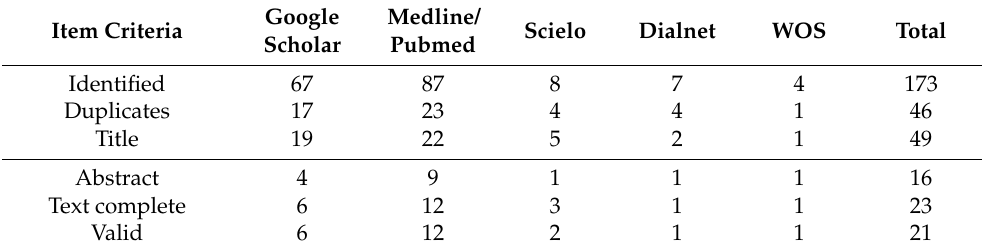
Table 1. Databases Table 1. Databases consulted.